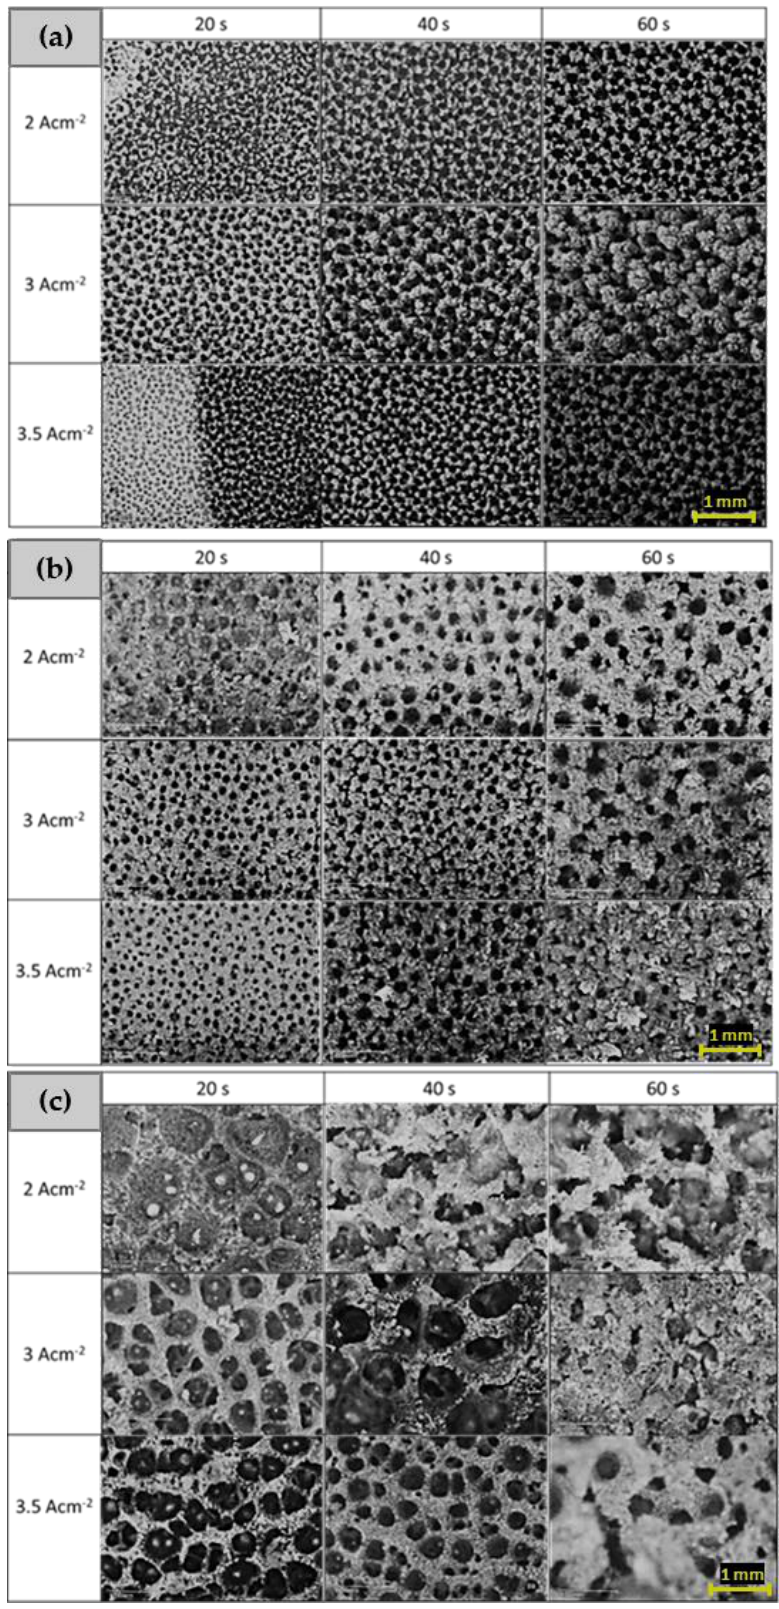
Figure 2. Surface morphology of the Cu electrodeposits in group ( a ) A, ( b ) B, and ( c ) C, prepared by varying applied current densities and deposition times.